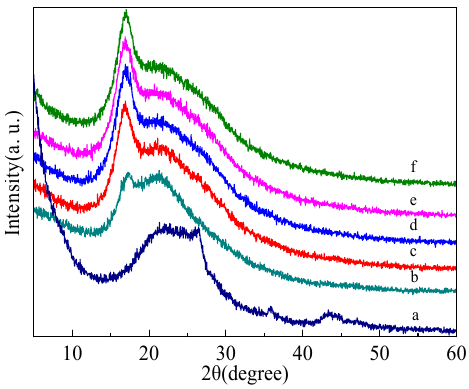
Figure 7. X-ray diffraction (XRD) spectra of ( a ) SWCNTs; ( b ) PAN nanofibers; and corresponding composite nanofibers with the different SWCNT concentrations of ( c ) 0.5 wt %; ( d ) 1 wt %; ( e ) 1.5 wt %; ( f ) 2 wt %.